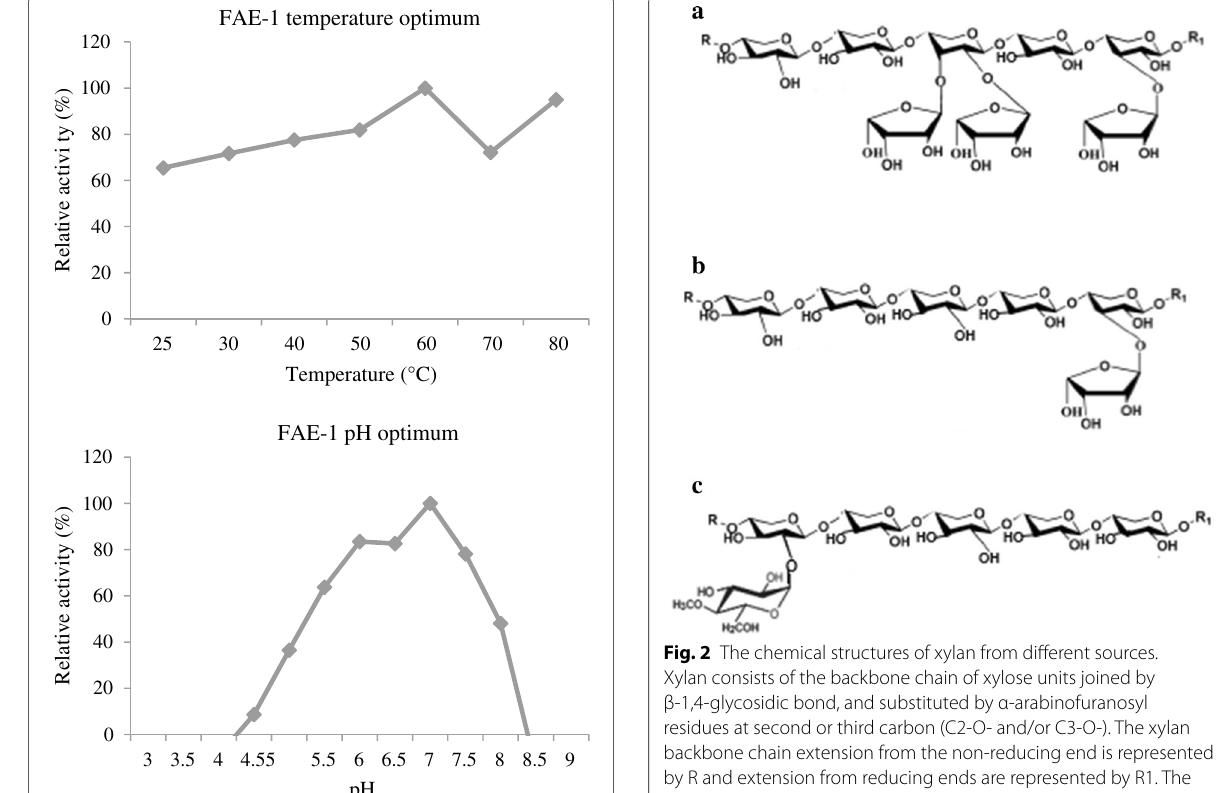
was the most substituted xylan substrate, consisting of about 30% more arabinose residues compared to OX. For every five xylose units of the backbone xylan, there were three substituted arabinose units in WAX (Fig. 2a).